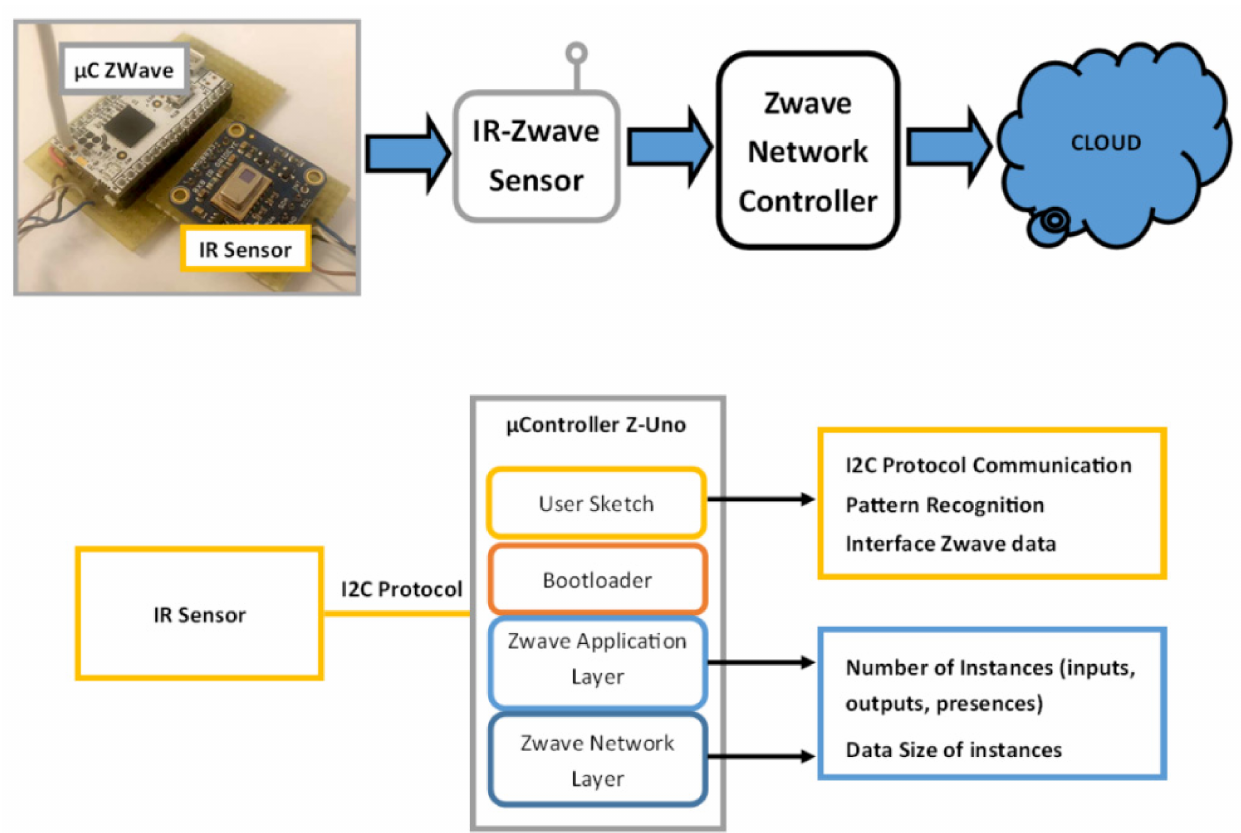
Figure 1. A schematic representation of the proposed